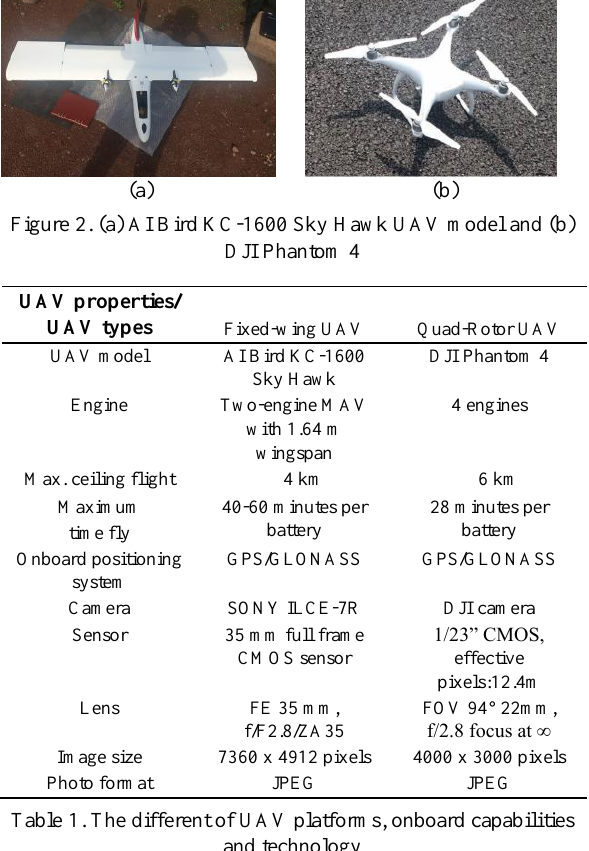
Table 3. GCP properties and data collected for this experiment